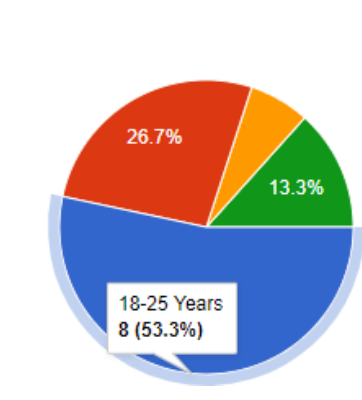
Figure A2. A survey report showing responders ages.